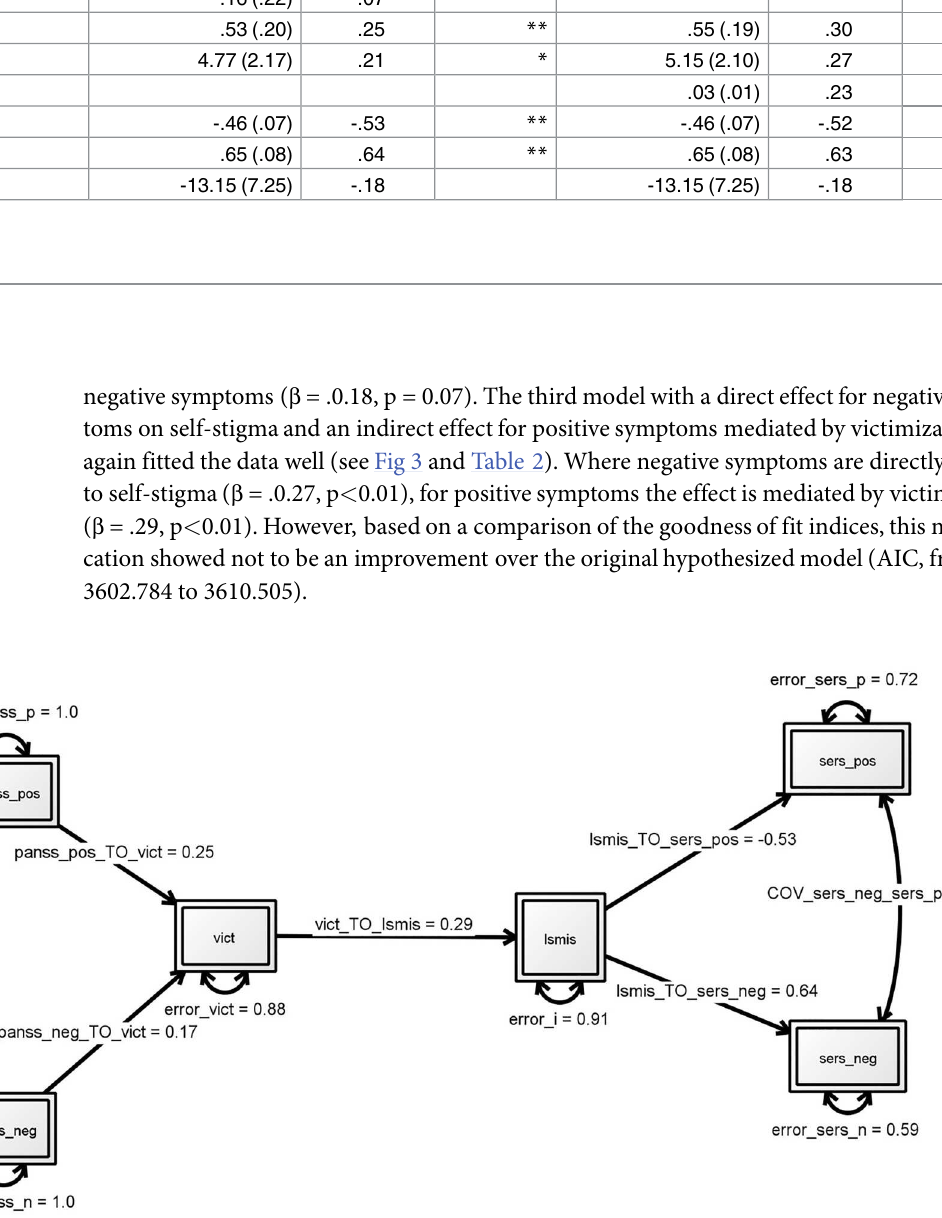
Fig 2. Second model: victimization mediating effects of symptoms on self-stigma and effect self- stigma on self- esteem. Structural equationmodeling.Numbers by single-headedarrows reflect standardized regressionweights. Fit indices: χ 2 = 12.272; df = 8; p = .1395, RMSEA (90%CI) = .072 (0-.128), SRMR = .0086, CFI = .961, TLI = .932, Akaike (AIC) 3615.103. * p < 0.05, ** p < 0.01. PANSS_pos: level of positive symptoms on PANSS, PANSS_neg: level of negative symptoms. ISMIS: total score on four subscales of the Internalized Stigma of Mental Illness Scale (alienation, stereotype endorsement, perceived discrimination, social withdrawal) indicatinglevel of self-stigma. SERS_pos:score on subscale positive self-esteem of the Self- Esteem Rating Scale-Short Form and SERS-neg: score on the subscale negative self-esteem.